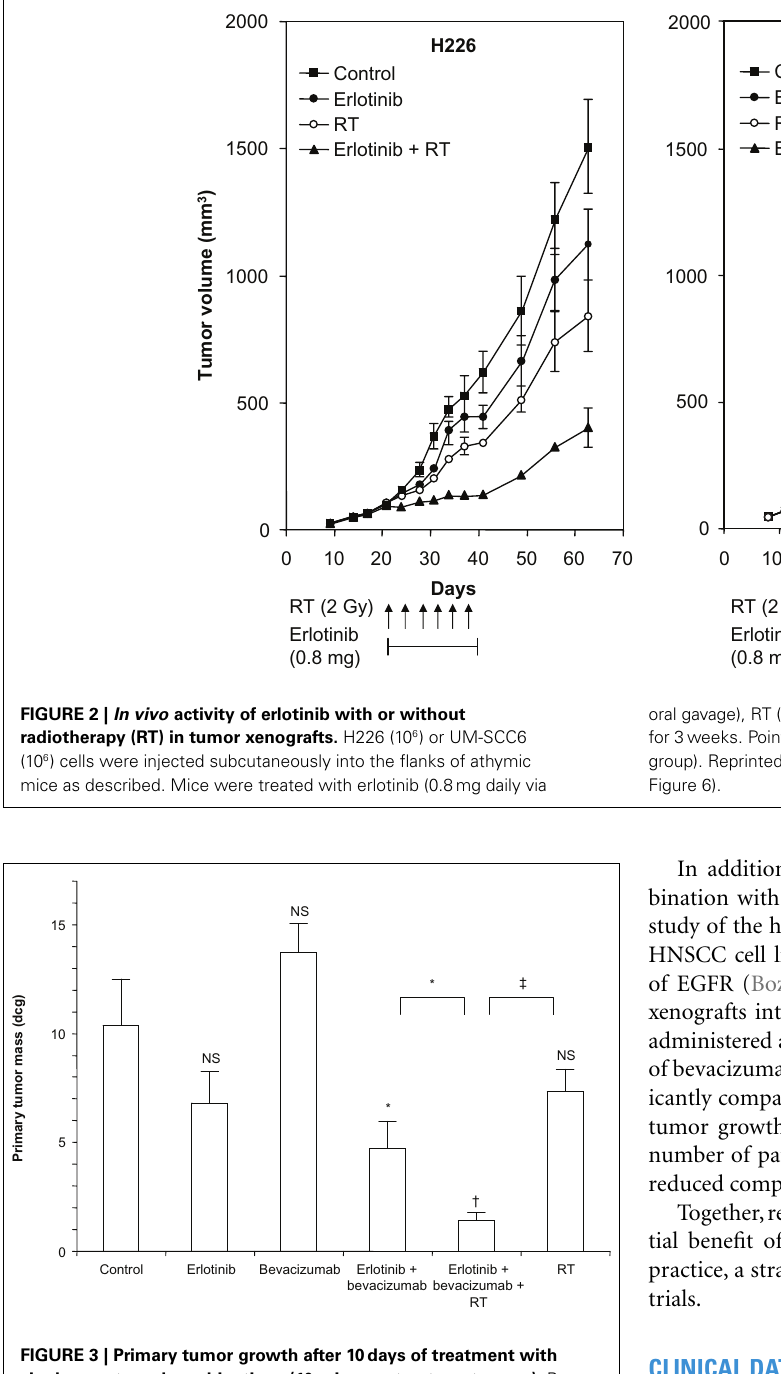
FIGURE 3 | Primary tumor growth after 10days of treatment with single agents and combinations (10 mice per treatment group). Bars denote SD.Values above the columns concern comparisons with the controls; other values concern comparisons between two following columns. * P < 0.05; † P < 0.01; ‡ P < 0.001; NS, non-significant ( P > 0.05); RT, radiotherapy. Reprinted by permission from (Bozec et al., 2008), copyright